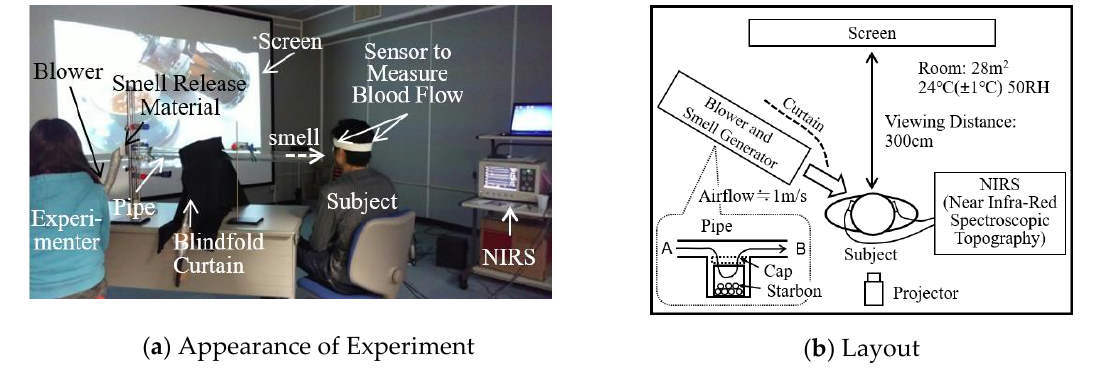
Figure 1. Illustration of the experimental conditions.